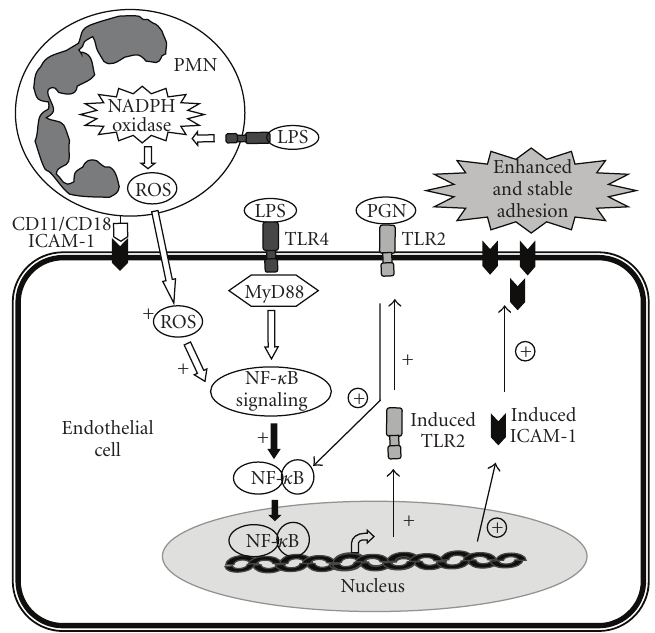
Figure 4: Role of PMN NADPH oxidase-derived oxidant signaling in mediating the TLR4-TLR2 cross talk in ECs. LPS stimulation induces NADPH oxidase activation and production of reactive oxygen species (ROS) in PMN as well as the initiation of MyD88-dependent NF- κ B signaling in ECs and the consequent expression of TLR2 and ICAM-1. Adhesion of PMN to ECs is mediated by the binding of constitutive ICAM-1 to CD18 integrin and provides the appropriate coupling required for PMN to transmit oxidant signals to ECs. The oxidants augment NF- κ B signaling and TLR2 expression (+), which result in the augmented response of the cell to PGN, thereby amplifying ICAM-1 expression (circled +) and promoting stable adhesion of PMN to ECs and increased PMN migration. Thus, the PMN NADPH oxidase-mediated TLR4-TLR2 cross talk activates a positive feedback signal leading to sustained and amplified endothelial activation in response to invading